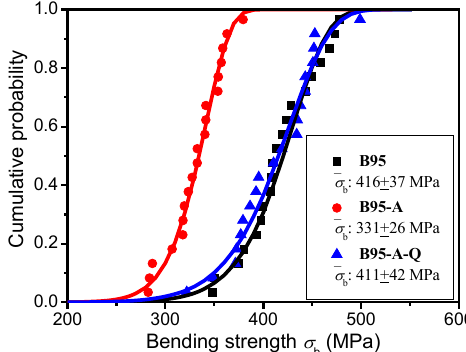
Fig. 6 Measured bending strength σ b data of B95 samples sorted in ascending order and the Weibull distribution fitting (lines). The inset data σ ¯ b is the average value of σ b with the standard